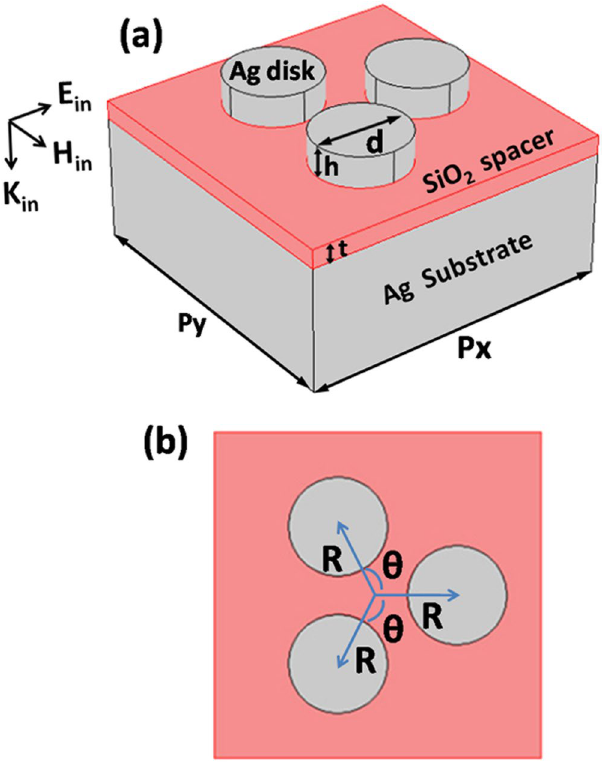
Figure 1. Oblique view ( a ) and top view ( b ) of metamaterials supporting a toroidal dipolar